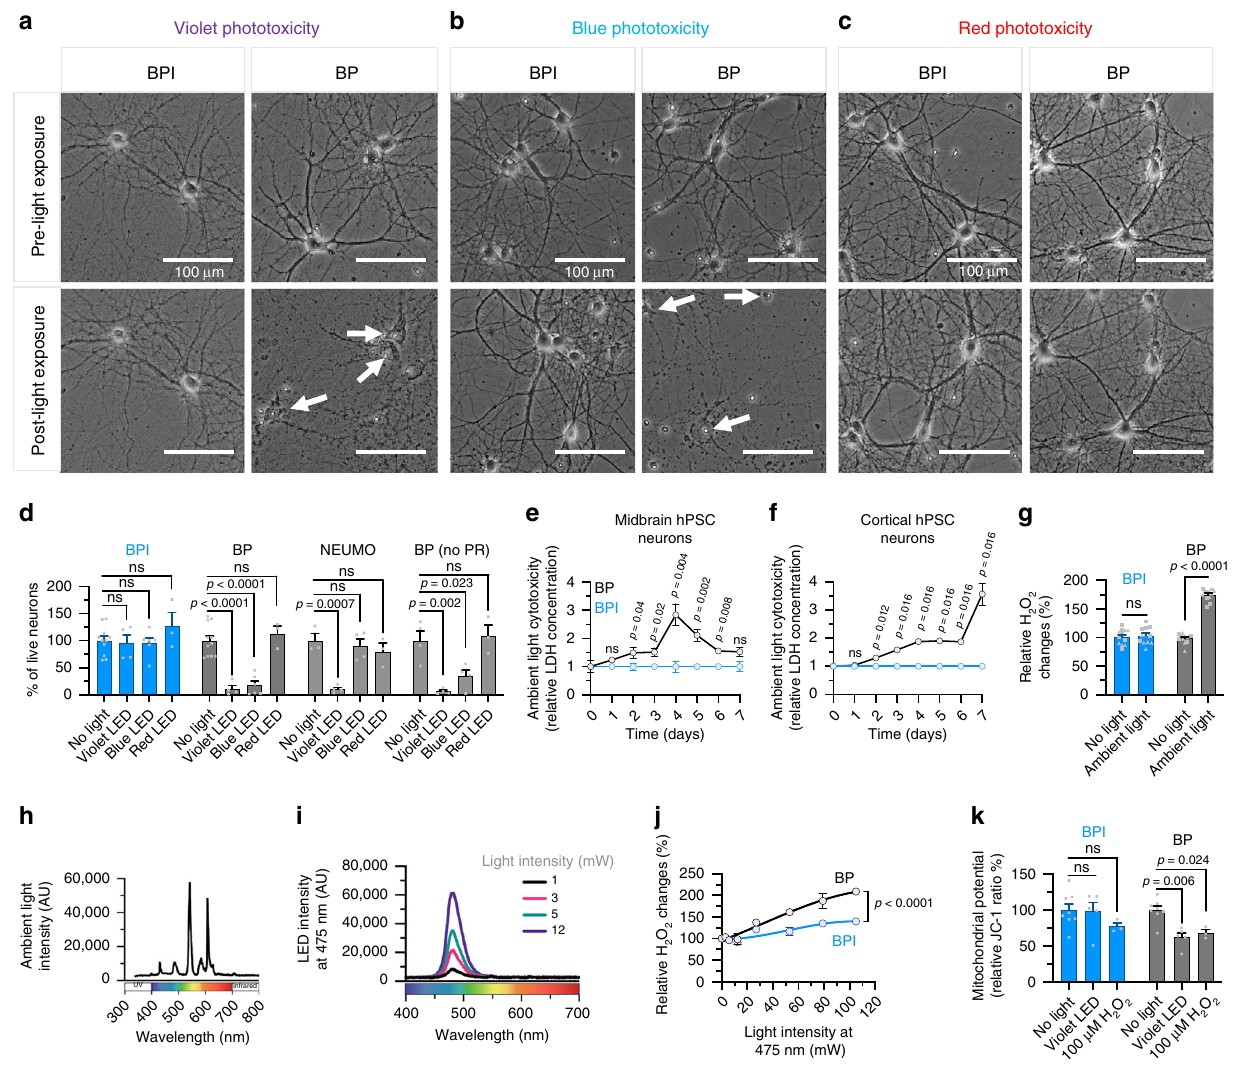
Fig. 3 BrainPhys Imaging minimizes phototoxicity. a – d Representative images of rat cortical primary neurons cultured in BrainPhys (BP) and BrainPhys Imaging (BPI) pre and post violet, blue and red LED exposure show dying neurons in BP (highlighted by white arrows). Each image is a representative cropped fi eld-of-view (FOV). See also Supplementary Fig. 5. d Only BPI maintained neuronal viability post violet and blue LED exposure compared to BP, NEUMO, and BP without phenol red (BP no PR). Red LED exposure caused no apparent phototoxicity. Data were collected across 3 – 5 independent experiments, each including 75 fi eld-of-views analyzed across three replicate wells. The number of neurons (per cm 2 ) post-light exposure were normalized to “ no light ” conditions. e , f Signi fi cant cytotoxicity in human midbrain (days 0 – 5: BPI and BP, n = 6 wells; days 6 – 7: BPI and BP, n = 5 wells) and cortical neurons (BP, n = 5; BPI, n = 4 wells) was seen when BPI and BP media (with supplements) were exposed to ambient tissue culture light for 24 h and fed to cells across 7 days. g Reactive oxygen species (H 2 O 2 ) in BP (without cells) was signi fi cantly increased following 24 h stimulation with ambient light, relative to BPI ( n = 12 wells per condition). Symbols represent cortical (triangle) or midbrain (square) supplements. h Ambient tissue culture light emission spectrum. i Blue LED light emission spectrum. j Relative H 2 O 2 levels of BPI and BP (without cells) after 24 h stimulation with blue LED light fl ashes over increasing power intensities ( n = 6 wells per condition). Data shown were normalized to “ no light ” conditions. See also Supplementary Fig. 4a, c. k Mitochondrial health of primary rat cortical neurons in BPI and BP (supplemented with SM1) was assessed using a mitochondrial membrane potential indicator (JC-1). Following 1 h violet LED light exposure or 100 µ M H 2 O 2 treatment, only neurons exposed to BPI maintained mitochondrial health. Data were collected across 3 – 5 independent experiments, across three biological replicates. Results are shown normalized to “ no light ’” conditions. See also Supplementary Fig. 4c. Data in d – g , j – k are presented as mean ± SEM. Signi fi cance determined via two-tailed unpaired t -test ( d ), two-tailed nonparametric unpaired (Mann – Whitney) test ( e – g , k ) and one-sided sum-of-squares F -test ( j ). Nonsigni fi cant P -values >0.05 are annotated with − 70 mV (by injecting on average 50 pA of current) and applied potential was around − 50 mV and their AP threshold approa- incremental depolarizing steps of current/voltage (Fig. 4a and ched physiological levels ( − 40mV) both in BPI and ACSF Supplementary Fig. 6d). Voltage-gated sodium/potassium cur- (Fig. 4c). No signi fi cant differences were found between the rents, rheobase, AP amplitude, AP frequencies, and AP hyper- membrane resistance and capacitance of neurons patch-clamped polarizing amplitudes were similar when the recording was in either BPI or ACSF (Fig. 4j, k). Our results demonstrate the made in BPI or in ACSF (Fig. 4c – i). When no current was capacity of human neurons to generate optimal action potentials injected in the patch-clamped neurons, their resting membrane in BPI.